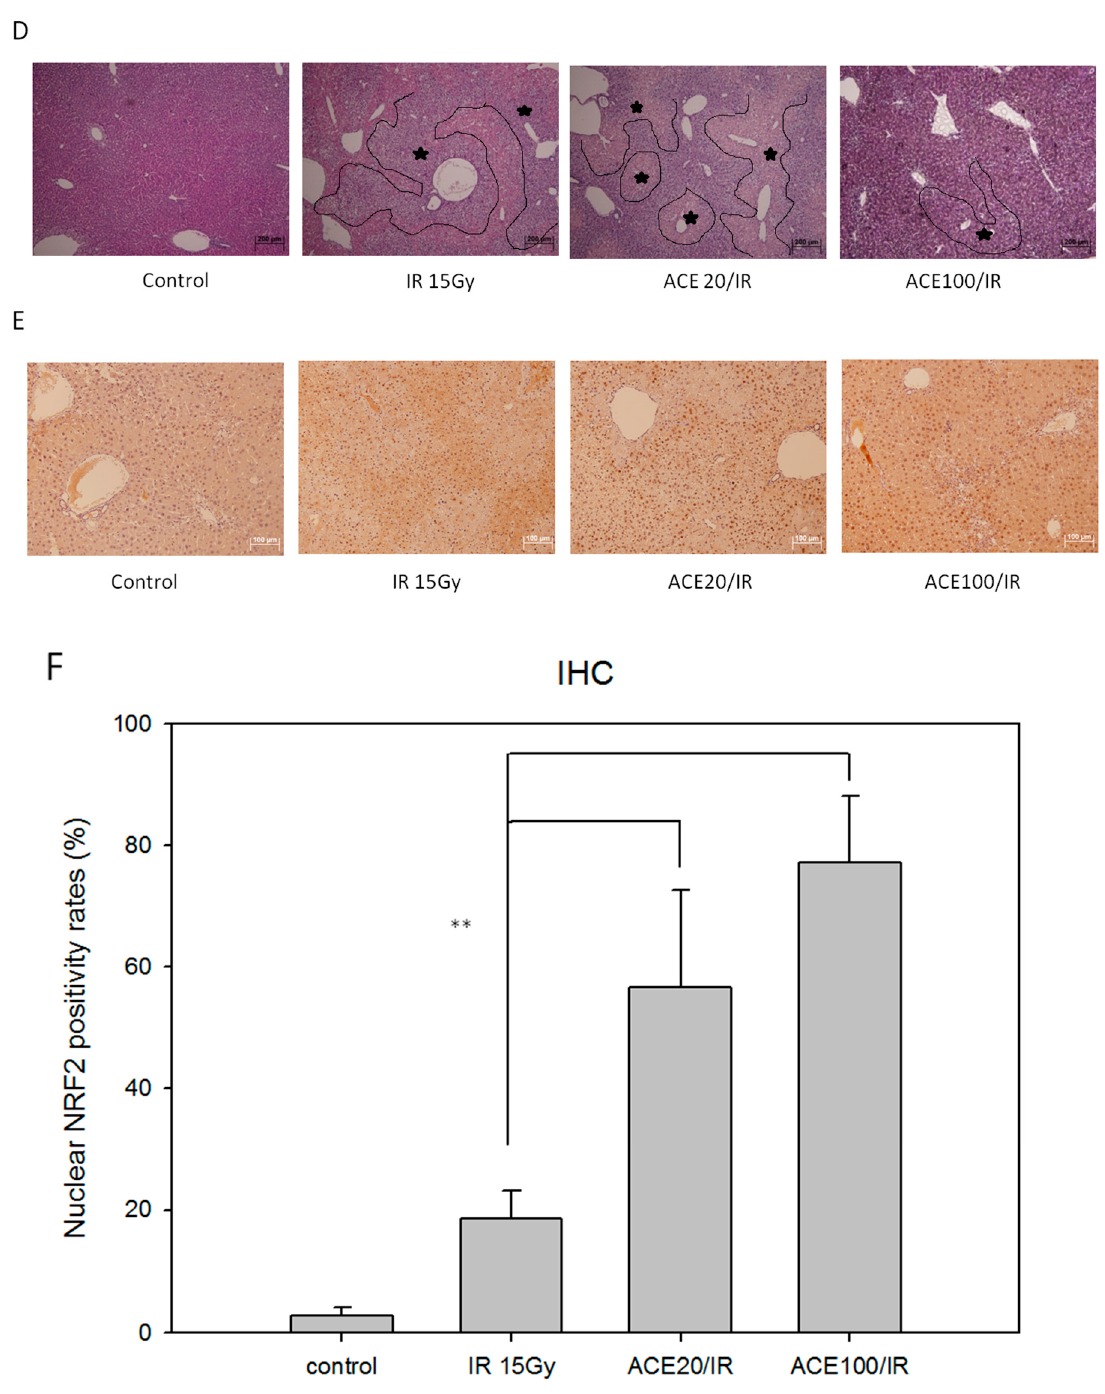
Figure 7. ACE alleviated the acute hepatitis markers in irradiated induces acute liver damage. ( A ) Scheme of the orthotropic hepatoma bearing mice model experiments. 48 h after irradiation, serum samples were collected every 24 h for monitoring the hepatitis markers aspartate transaminase (AST) ( B ) and alanine transaminase (ALT) ( C ). Liver tissues were harvested 96 h, upon sacrifice, and haematoxylin and eosin (H&E) stained for morphological detection of hepatic inflammation extent (the areas within black lines and marked with asterisks) ( D ) and Immunohistochemical (IHC) stained for Nrf2 detection ( E ). ( F ) The nuclear Nrf2 positivity rates were plotted. Results were obtained from random fields of three mice liver tissue sections for each group. *, p < 0.05; **, p < 0.01, as compared with the IR15Gy group.